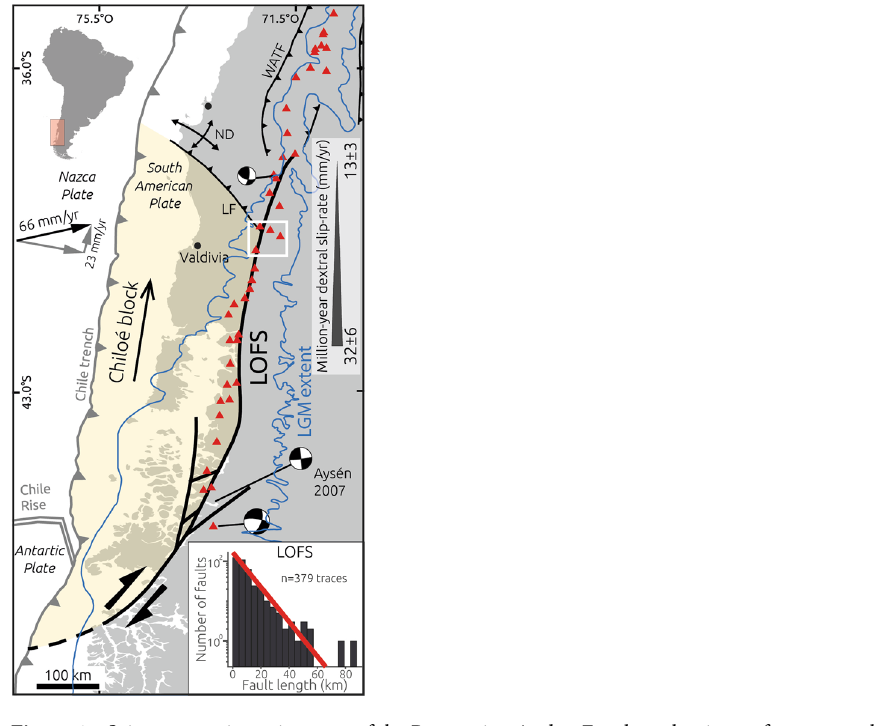
Figure 1. Seismotectonic setting map of the Patagonian Andes. Focal mechanisms of mayor earthquakes along the Liquiñe-Ofqui Fault System (LOFS) from the CMT Catalogue. Black and grey arrows show Nazca- South America plate convergence vector 39 and decomposed margin-normal and margin-parallel